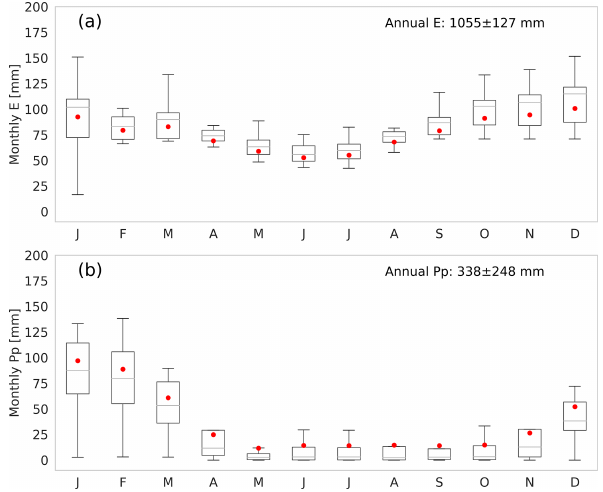
Figure 6. Seasonal variability of monthly (a) evaporation (E) and (b) precipitation (Pp) rates during the 1950–2020 period. The boxes represent the 25%–75% interquartile, the gray horizontal line is the median, the red dots are the mean, and the bars represent maxi- mum and minimum values. Outliers have been removed and annual evaporation and precipitation have been calculated over the entire period.